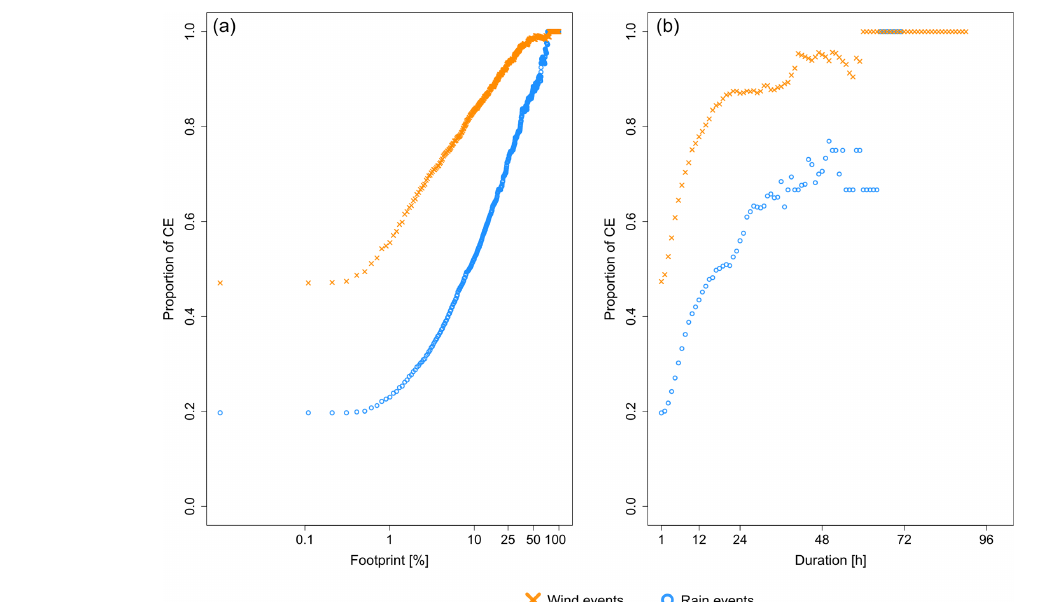
Figure A1. Proportion of compound wind–precipitation clusters among wind clusters (orange) and precipitation clusters (blue) depending on (a) footprint and (b) duration of the hazard